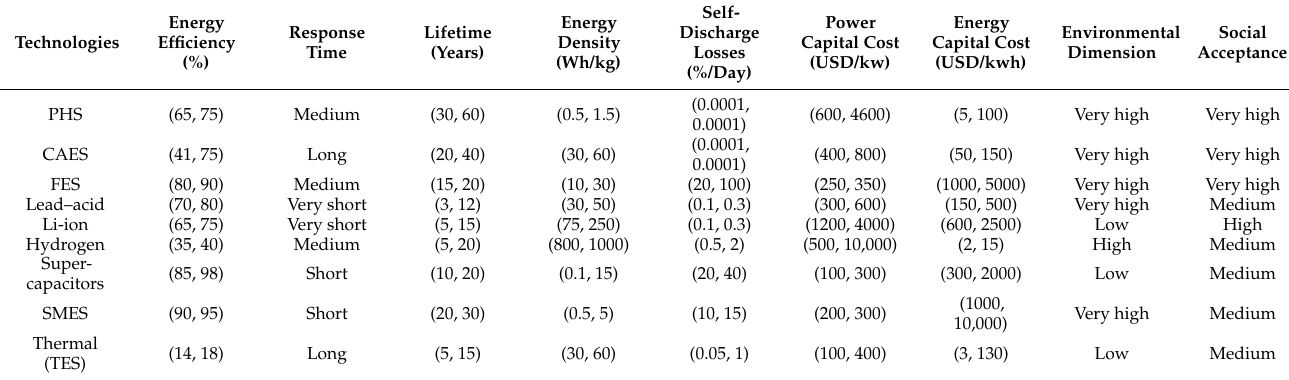
Table A7. Decision basic data of Expert